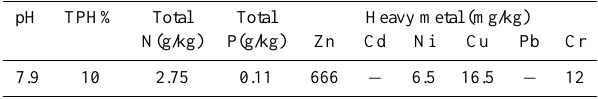
Table 1. Chemical properties of the soil used in the